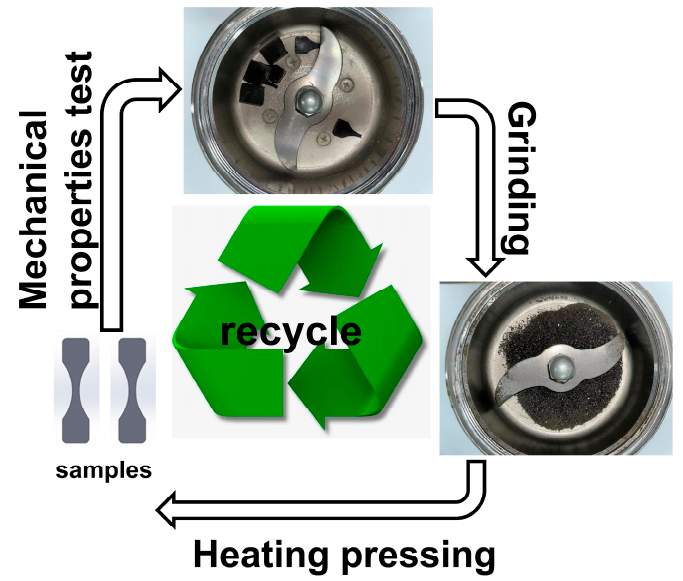
Table 2. Mechanical Properties of MSiCw-1-MGO-0.3-PI composites after three generations.